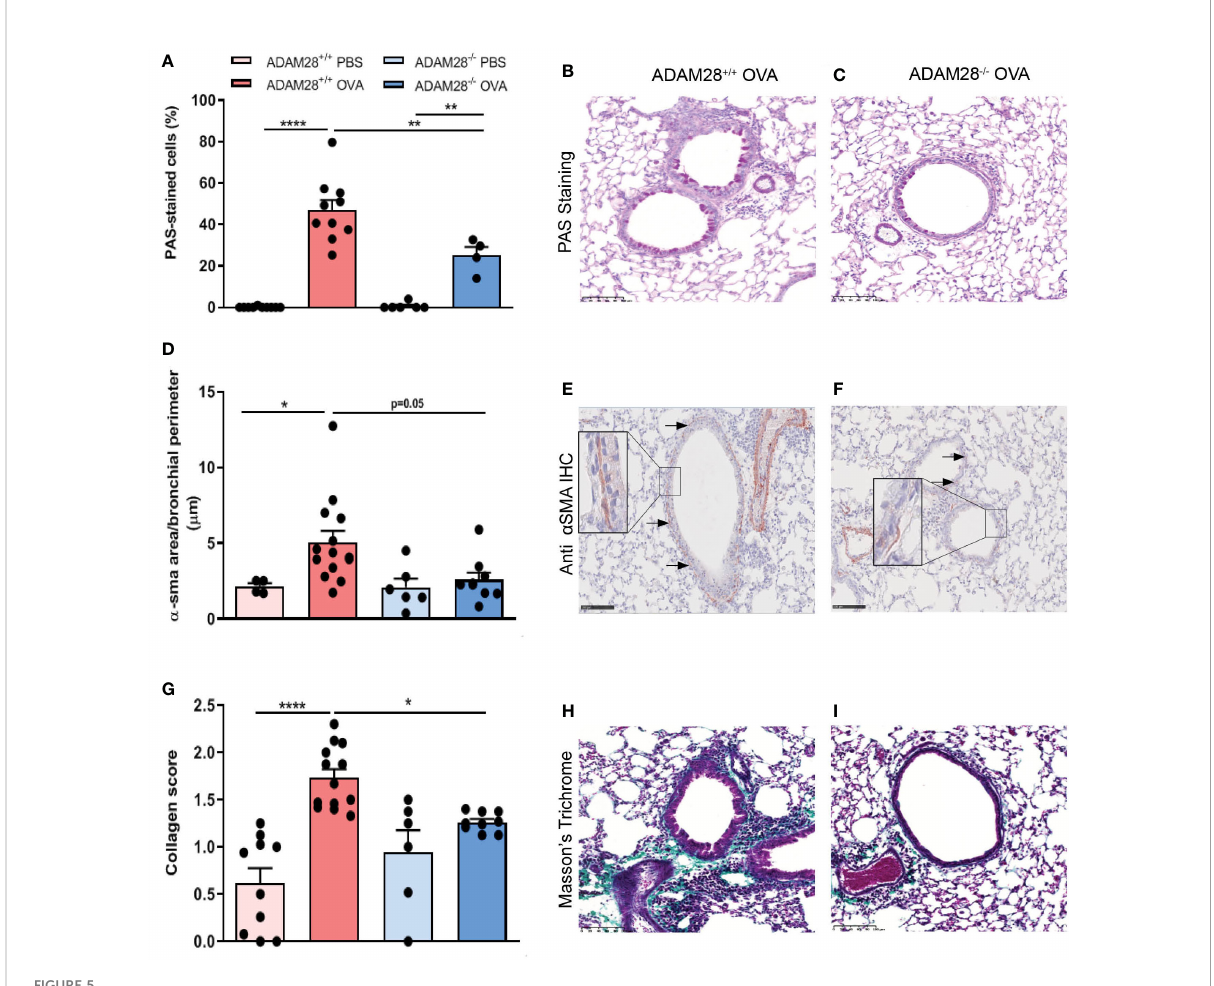
FIGURE 5 Assessment of airway remodelling in the lung of ADAM28 -/- and ADAM28 +/+ mice exposed to allergens for 90 days (LT protocol). (A) Quanti fi cation of the percentage of PAS-positive epithelial cells per bronchi (N=2; ADAM28 +/+ - PBS n=10, ADAM28 +/+ - OVA n=10, ADAM28 -/ – PBS n=6, ADAM28 -/ – OVA n=5). (B, C) Representative PAS staining of lung sections of ADAM28 +/+ and ADAM28 -/- mice exposed to OVA. Scale bar: 100 m m. (D) Assessment of smooth muscle area around the bronchi stained by IHC against a -SMA reported to perimeter of the epithelial basement membrane (mean of 7 bronchi per mouse) (N=2; ADAM28 +/+ - PBS n=4, ADAM28 +/+ - OVA n=14, ADAM28 -/ – PBS n=6, ADAM28 -/ – OVA n=9). (E, F) Representative IHC with an anti- a -SMA in lung sections of ADAM28 +/+ and ADAM28 -/- mice exposed to OVA. Scale bar: 100 m m. (G) . Collagen deposition score related to the thickness collagen (mean of 7 bronchi randomly selected per mouse, each one scored from 0 to 3) (N=2; ADAM28 +/+ - PBS n=10, ADAM28 +/+ - OVA n=13, ADAM28 -/ – PBS n=6, ADAM28 -/ – OVA n=9). (H, I) Collagen stained by Masson ’ s Trichrome staining of lung sections of ADAM28 +/+ and ADAM28 -/- mice exposed to OVA. Scale bar: 100 m m. Results are represented as the mean ± SE. *p<0.05, **p<0.01, ***p<0.001 (One way